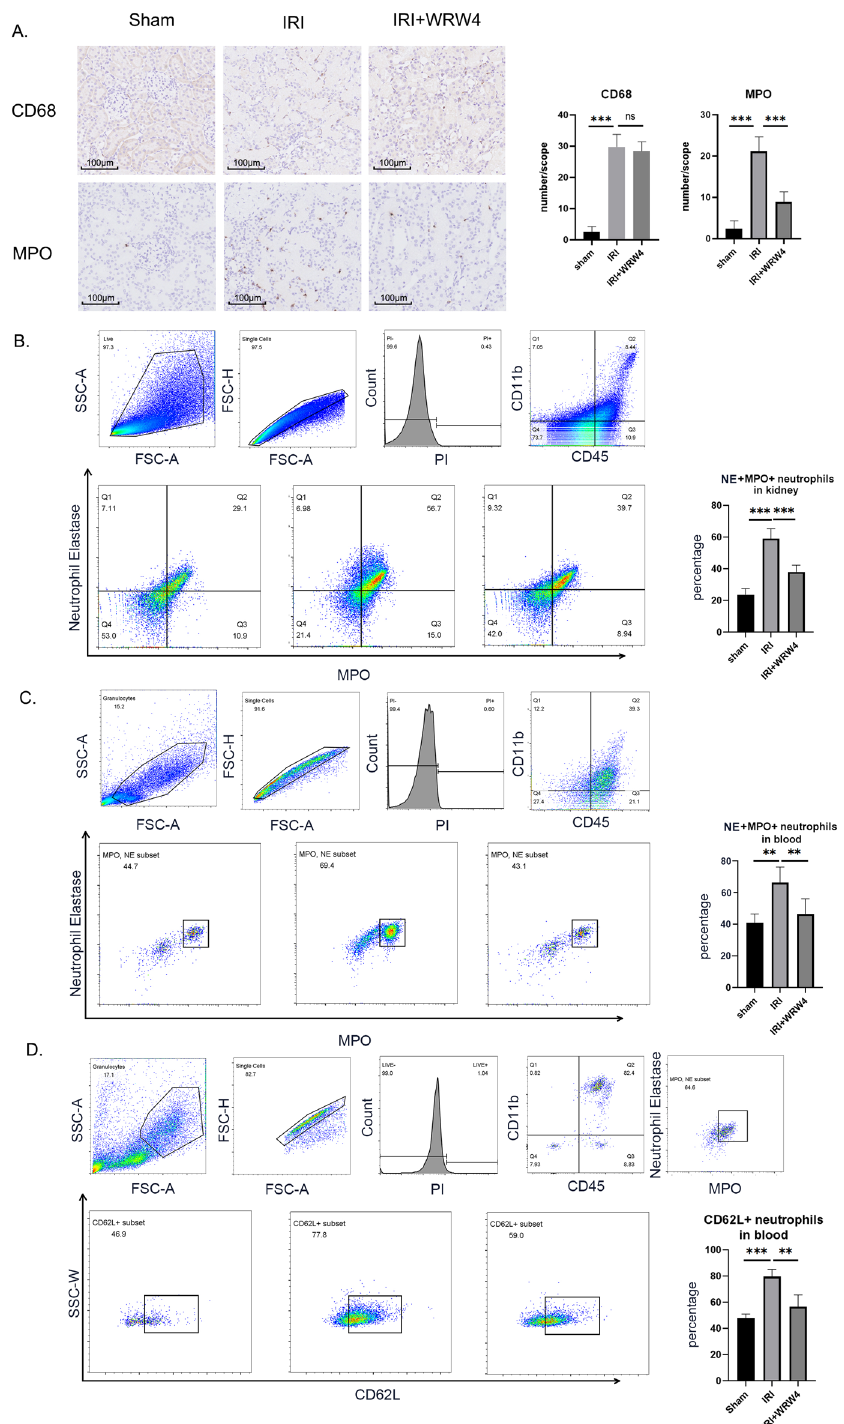
Fig. 2 (See legend on previous